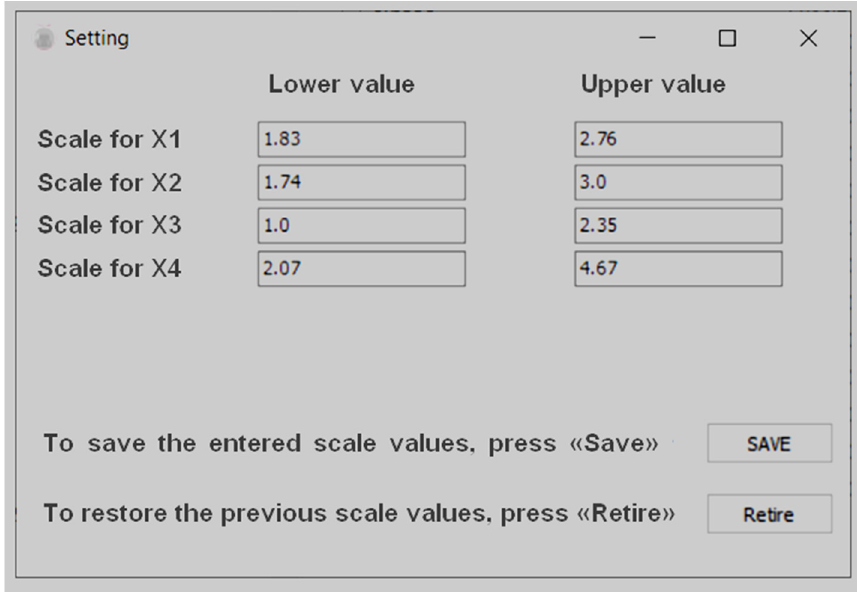
Figure 6. Function of entering minimum and maximum values for each factor.